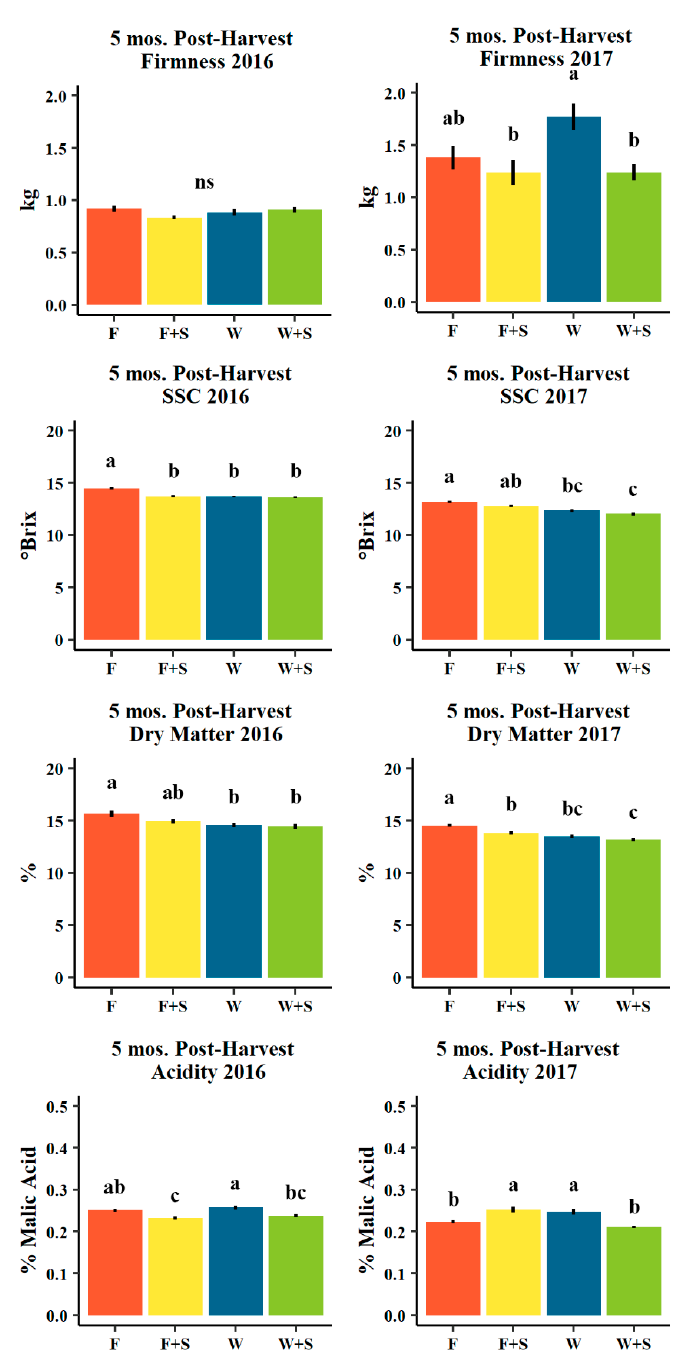
Figure 8. Mean firmness (kg, n = 457 and 253 in 2016 and 2017, respectively), soluble solids content (SSC, °Brix, n = 457 and 253 in 2016 and 2017, respectively), destructively measured actual dry matter (%, n = 95 and 173 in 2016 and 2017, respectively), and acidity (% malic acid, n = 57 and 45 in 2016 and 2017, respectively) for d’Anjou fruit evaluated five mos. post-harvest (five months after harvest in cold storage plus seven days of ripening at room temperature) in 2016 (left) and 2016 (right) among seasonal pruning treatments consisting of fall pruning (F, orange), fall and summer pruning (F+S, yellow), winter pruning (W, blue), and winter and summer pruning (W+S, green). Error bars indicate ± standard error. Different letters indicate significance difference among means ( p < 0.05, Tukey HSD). “ns” indicates no significant difference among means ( p > 0.05, Tukey HSD). At harvest gross incidence of defects reported approximately a 2% of pears afflicted by sunburn with no macroscopic differences between the treatments in 2016, while in 2017 sunburn was almost